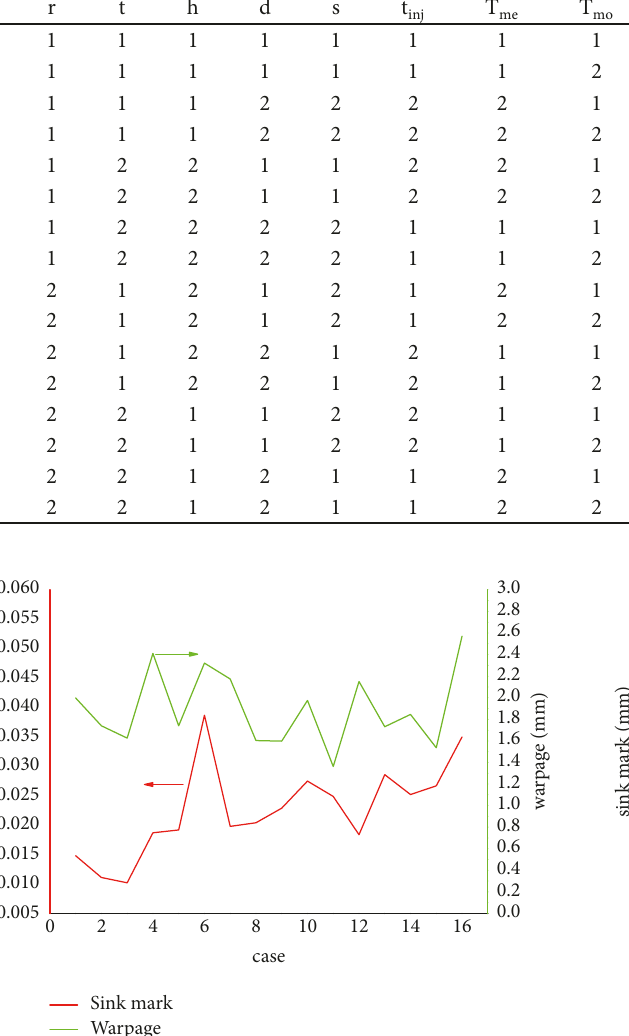
SE Coeff values shown in Table 9 are small enough to ensure that the coefficients in the model are reasonable. T